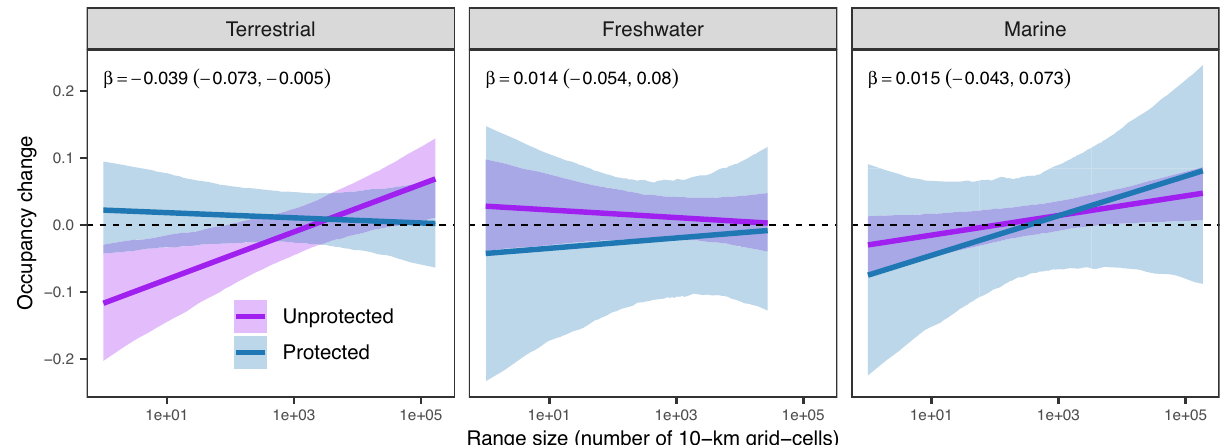
Fig. 3|Effect ofhabitat protectionontherelationshipbetween rangesizeand occupancy change for terrestrial, freshwater, and marine realms. The coef fi - cient ( β ) of the interaction between range size and proportion of sites that occur withinprotectedareasforeachrealmandits95%credibleintervalareshownatthe top. The purple solid lines show the predicted relationship when no sites within a